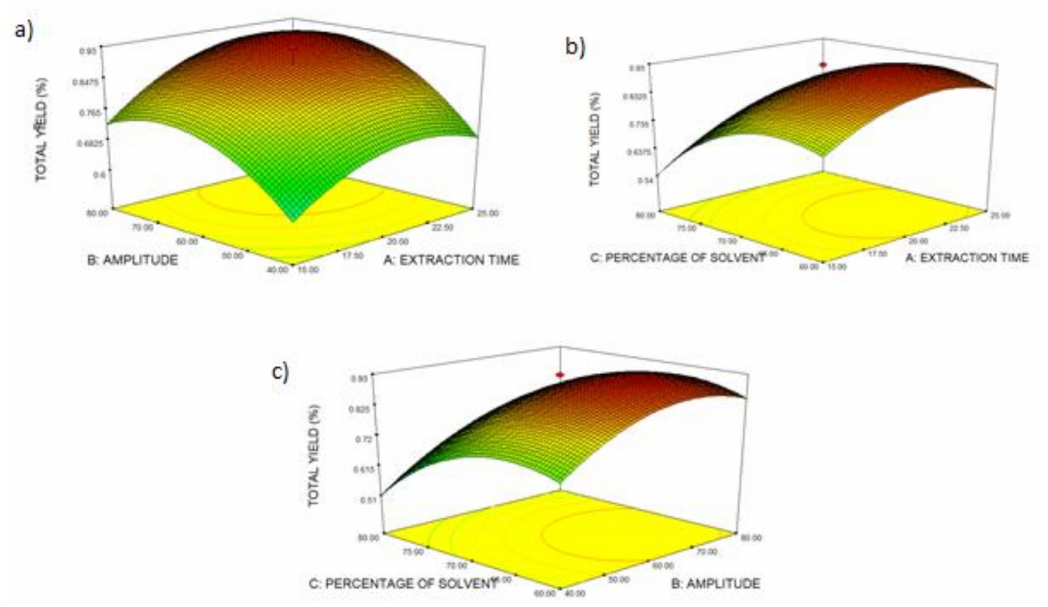
Figure 4. Surface plot of total yield of Orthosiphon stamineus (OS) extract: ( a ) extraction time and amplitude, ( b ) extraction time and percentage of solvent, ( c ) amplitude and percentage of